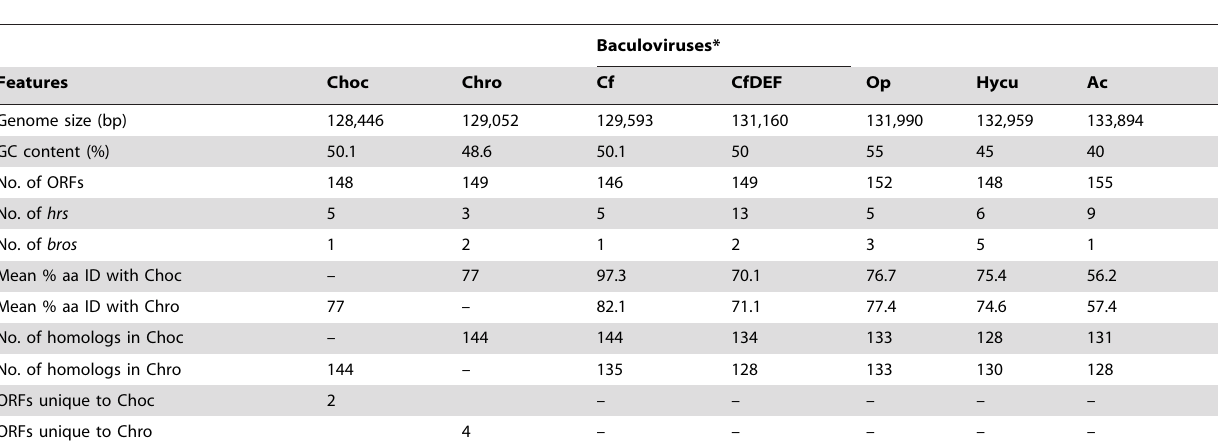
Table 1. Characteristics of ChocNPV and ChroNPV genomes.